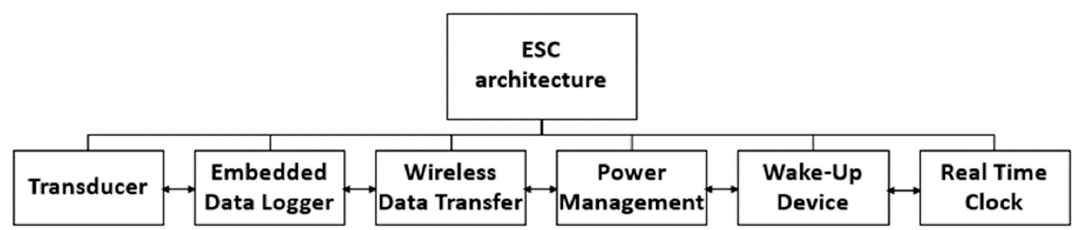
Figure 1. ESC ™ (Easy Sense & Connect) architecture used for AgriLogger Figure 1. ESC TM (Easy Sense & Connect) architecture used for AgriLogger manufacturing.